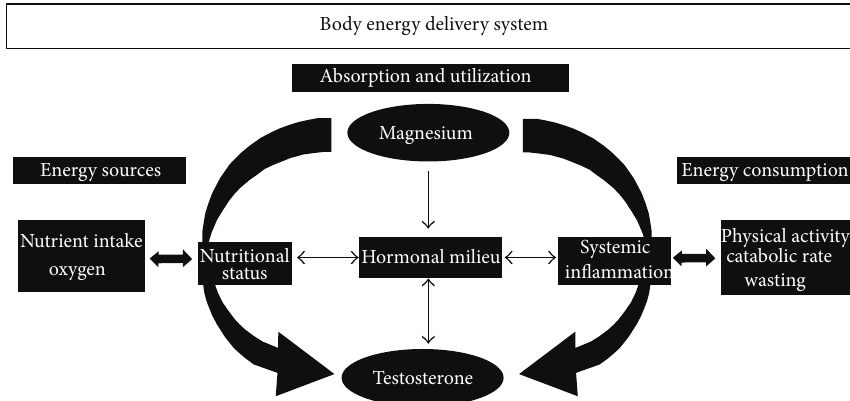
Figure 2: Relationship between Testosterone and magnesium, potential underlying mechanisms and clinical implications. The aging process is frequently characterized by an impaired homeostatic reserve due to an imbalance between energy assumption (left side) and utilization and consumption (middle and right sides). The activity of anabolic hormones, where T plays a central role, is influenced by mineral status (magnesium), along with caloric and protein intake. The systemic inflammation, which negatively influences magnesium and T and is in turn downregulated by these 2